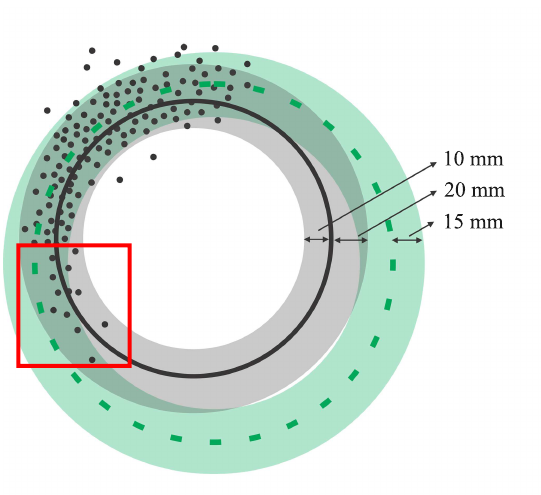
Figure 7. The asymmetric thresholds for circle fitting. The black circle is the one determined by our algorithm. The dotted green circle is over fitted and determined by symmetric thresholds. When using symmetric thresholds, the points in the red rectangle have weak effects; thus, the fitted circle is biased by the unbalanced weights introduced by the point